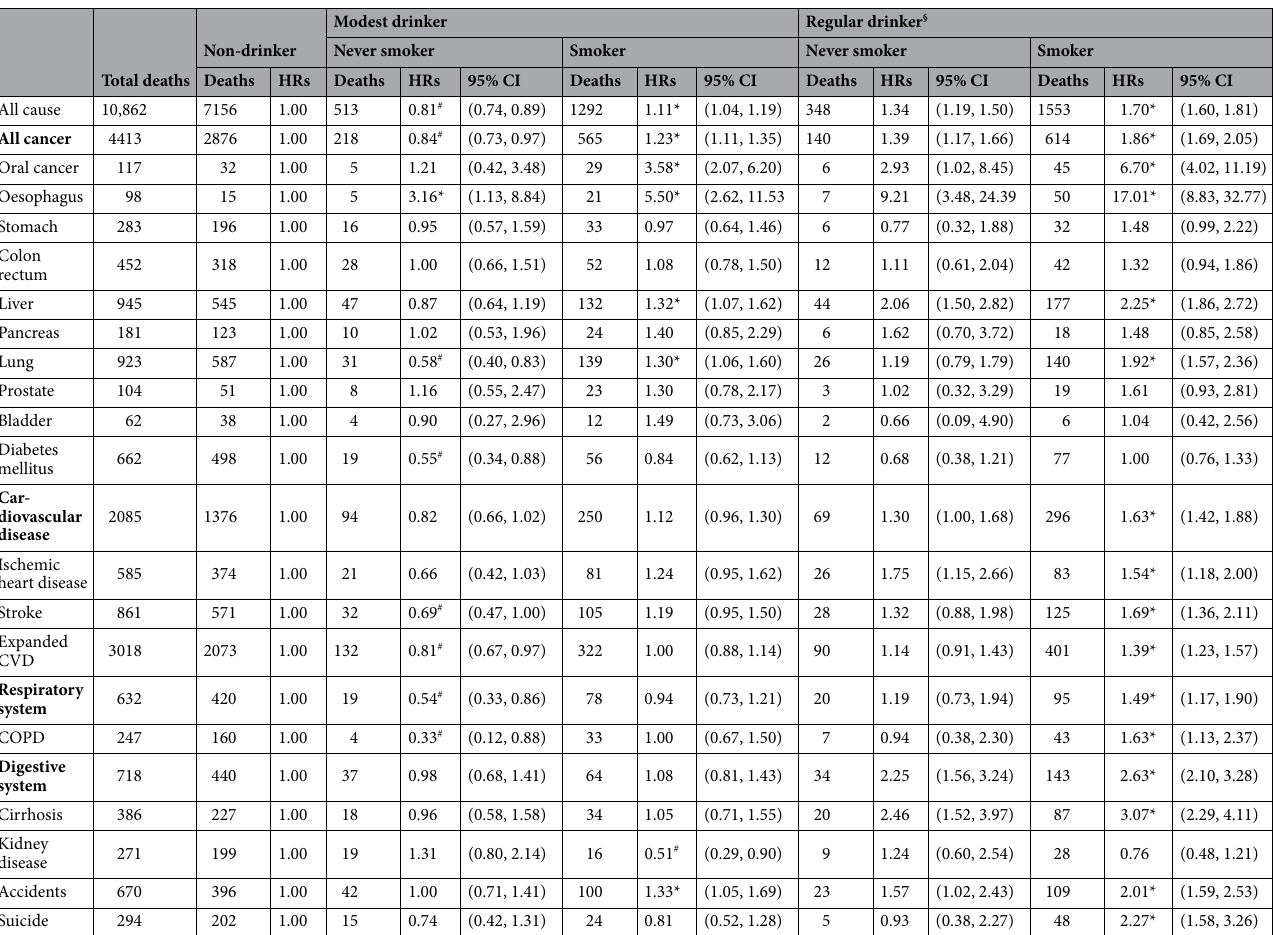
Table 3. Mortality risks by alcohol drinking and smoking status, compared to non-drinker. Hazard ratios are adjusted for age, education, body mass index, physical activity, systolic blood pressure, fasting blood glucose, anemia, total cholesterol, high-density lipoprotein cholesterol, low-density lipoprotein cholesterol, triglycerides, proteinuria, uric acid level and C-reactive protein in a multivariate Cox model when